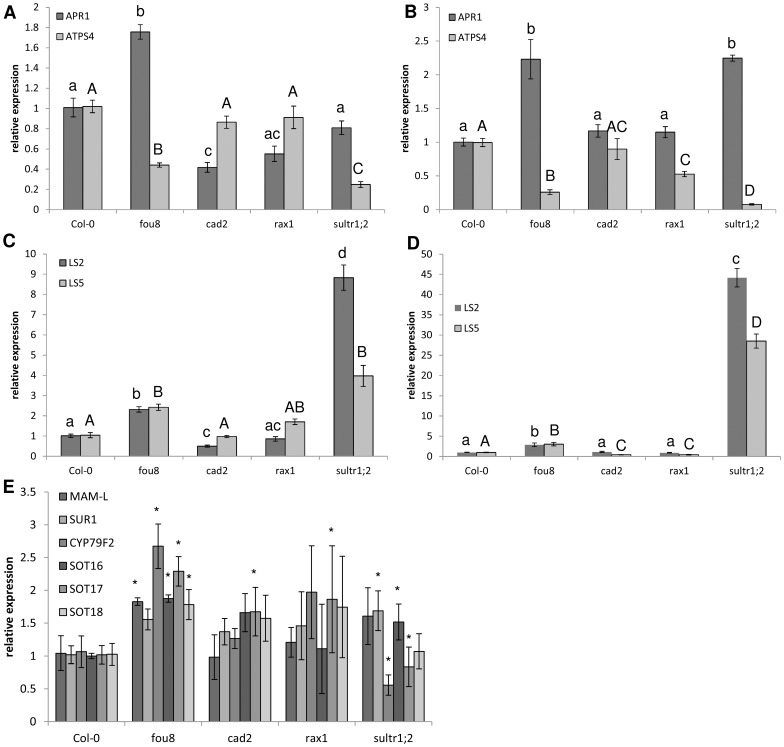
Comparison of mRNA levels of key genes of sulfur metabolism.Col-0, fou8, cad2, rax1, and sultr1;2 plants were grown for 2.5 weeks on MS-agarose plates. Relative mRNA levels of ATPS4 and APR1 in A leaves and B roots and of LS2 (At5g48850) and LS5 (At5g26220) in C leaves and D roots and genes of glucosinolate synthesis in E leaves were determined. The qRT-PCR reactions were performed in triplicate, the values in Col-0 were set to 1 for all genes. Results are presented as means ± SE from six biological replicates from plants grown in two independent experiments. Different letters mark values significantly different at P<0.05 or in E asterisks show values significantly (P<0.05) different from Col-0.